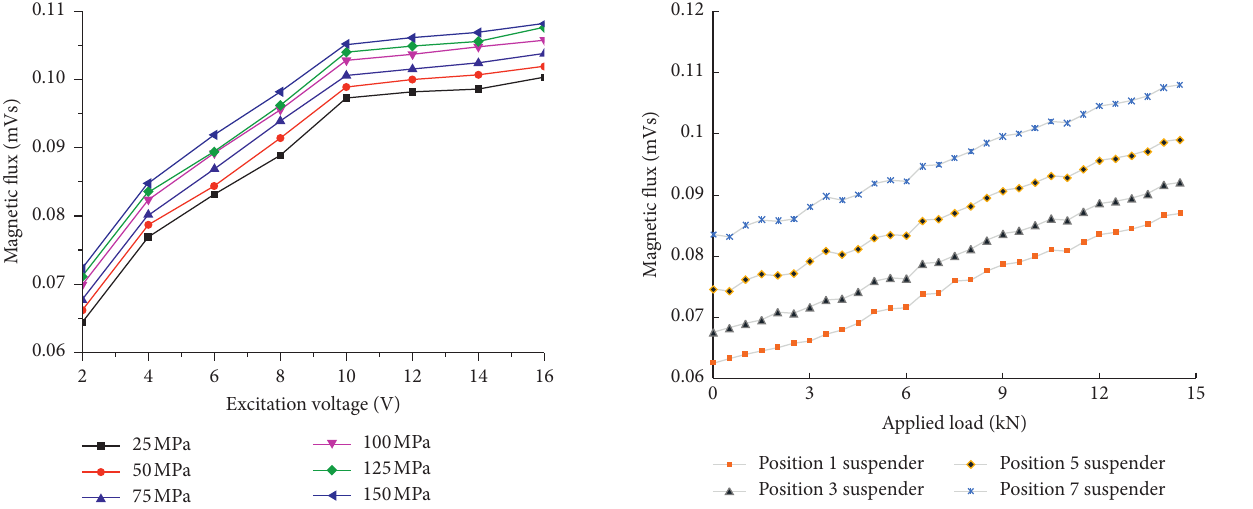
Figure 7: Relationships between the excitation voltage and mag- netic flux of No. 1 position suspender.